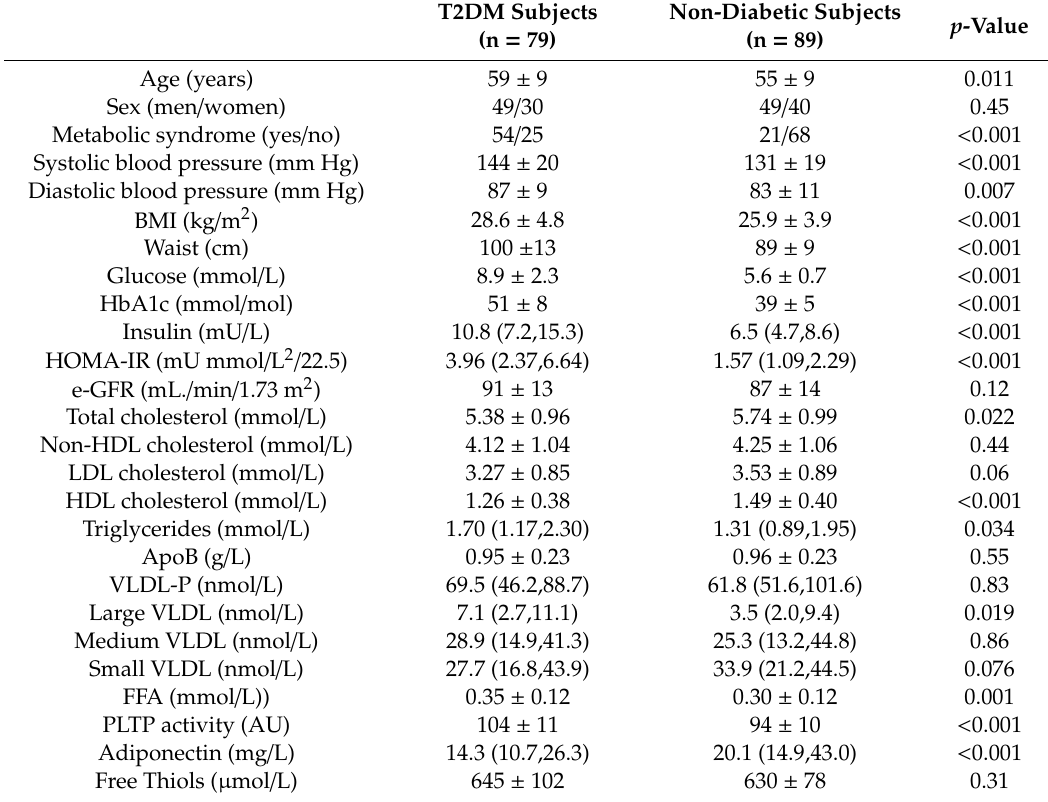
Table 1. Clinical and laboratory characteristics in 79 subjects with Type 2 diabetes mellitus (T2DM) and 89 subjects without